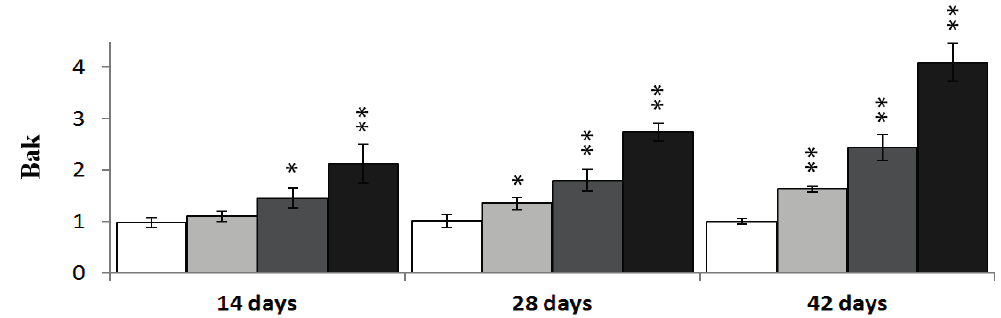
Figure 12. The mRNA expression levels of Bcl-2, Bcl-xL, Bax and Bak in the kidney. Data are presented with the mean ± standard deviation ( n = 5); * p < 0.05, compared with the control group; ** p < 0.01, compared with the control group.